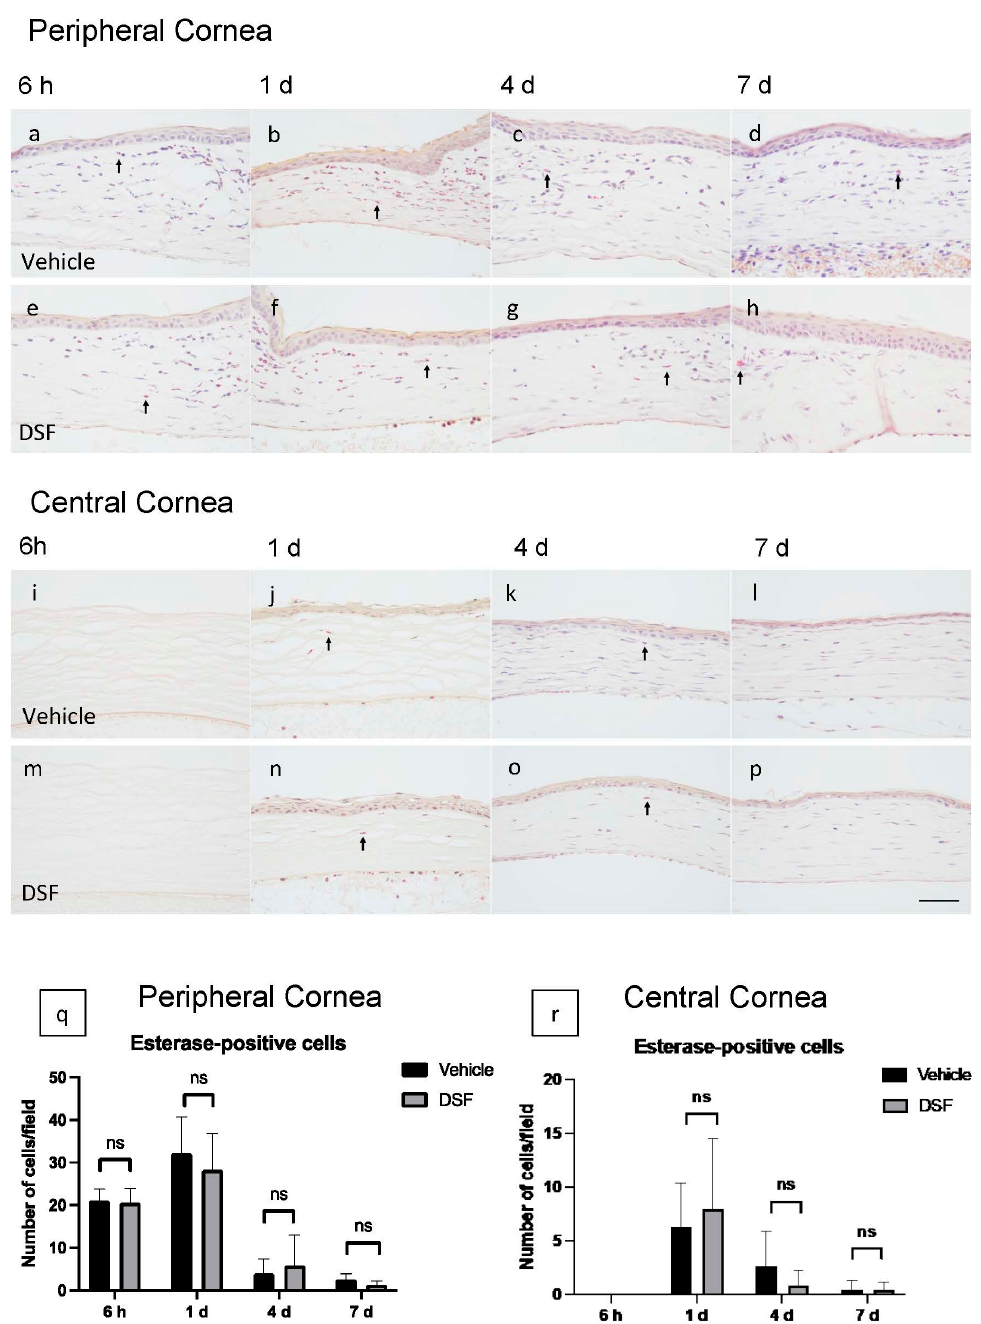
Figure 3. Esterase (EST) staining was performed to evaluate infiltrating neutrophils in the rat cornea after alkali burn. Immunohistochemical images of the peripheral cornea at 6 h and 1, 4, and 7 days are shown (Vehicle group: ( a – d ), DSF group: ( e – h )). Immunohistochemical images of the central cornea at 6 h and 1, 4, and 7 days are shown (Vehicle group: ( i – l ), DSF group: ( m – p )). The number of EST-positive cells infiltrating the four endpoints in the Vehicle and DSF groups were compared. In the peripheral cornea, there was no statistically significant difference in any of the endpoints ( q ). No statistically significant differences were also found in the central cornea ( r ). Bar, 50 μ m. The black arrows indicate EST-positive cells. Data are presented as mean ± standard error ( n = 8 samples/group). ”ns” means no significant difference.